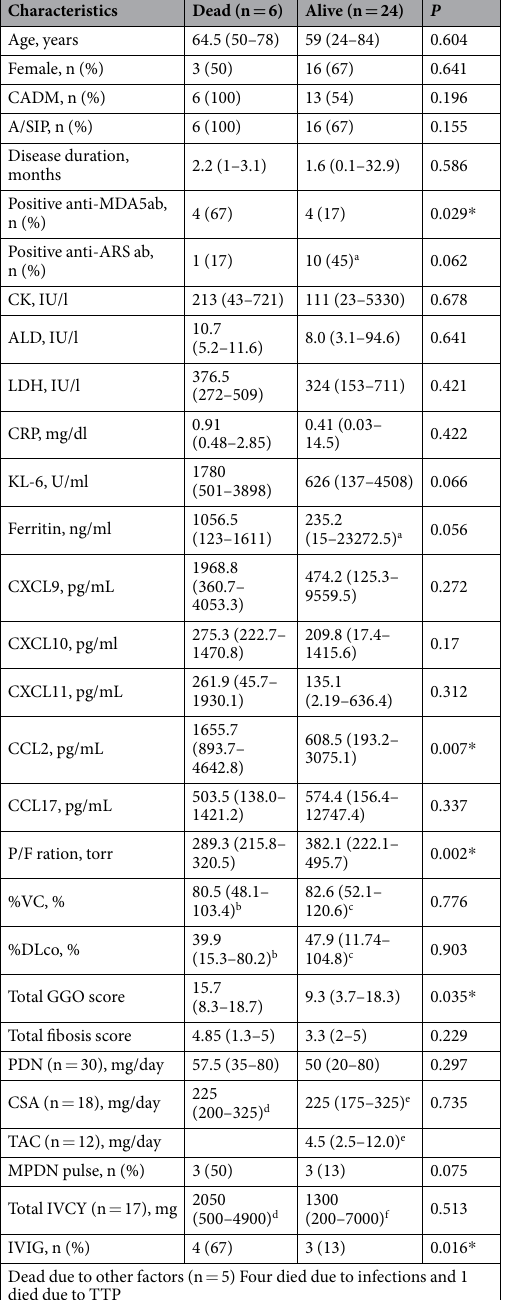
Table 1. Comparison of clinical characteristics, chemokine levels, and contents of treatment between in survivors and dead. The laboratory markers are presented as the median (interquartle range). The P -values were estimated using Fisher’s exact test or Mann-Whitney U- test. * P < 0.05. Dead: dead due to interstitial pneumonia; CADM: clinically amyopathic dermatomyositis; A/SIP: acute/subacute interstitial pneumonia; MDA5: melanoma differentiation-associated gene 5; ARS: aminoacyl-tRNA synthetase; ab: antibody; CK: creatine kinase; ALD: aldolase; LDH: lactate dehydrogenase; CRP: C-reactive protein; KL-6: Krebs von den Lungen-6; CXCL: C-X-C motif chemokine ligand; CCL: C-C motif chemokine ligand; P/F: PaO 2 /FiO 2 ; VC: Vital capacity; DLco: diffusion capacity of the lung for carbon monoxide; GGO: ground-glass opacity; PDN: prednisolone; CSA: cyclosporine; TAC: tacrolimus; MPDN pulse: methylprednisolone pulse therapy; IVCY: intravenous pulse cyclophosphamide; IVIg: intravenous immunoglobulin; TTP: thrombotic thrombocytopenic purpura. a Number of subjects, n = 23. b Number of subjects, n = 4. c Number of subjects, n = 19. d Number of subjects, n = 6. e Number of subjects, n = 12. f Number of subjects, n =